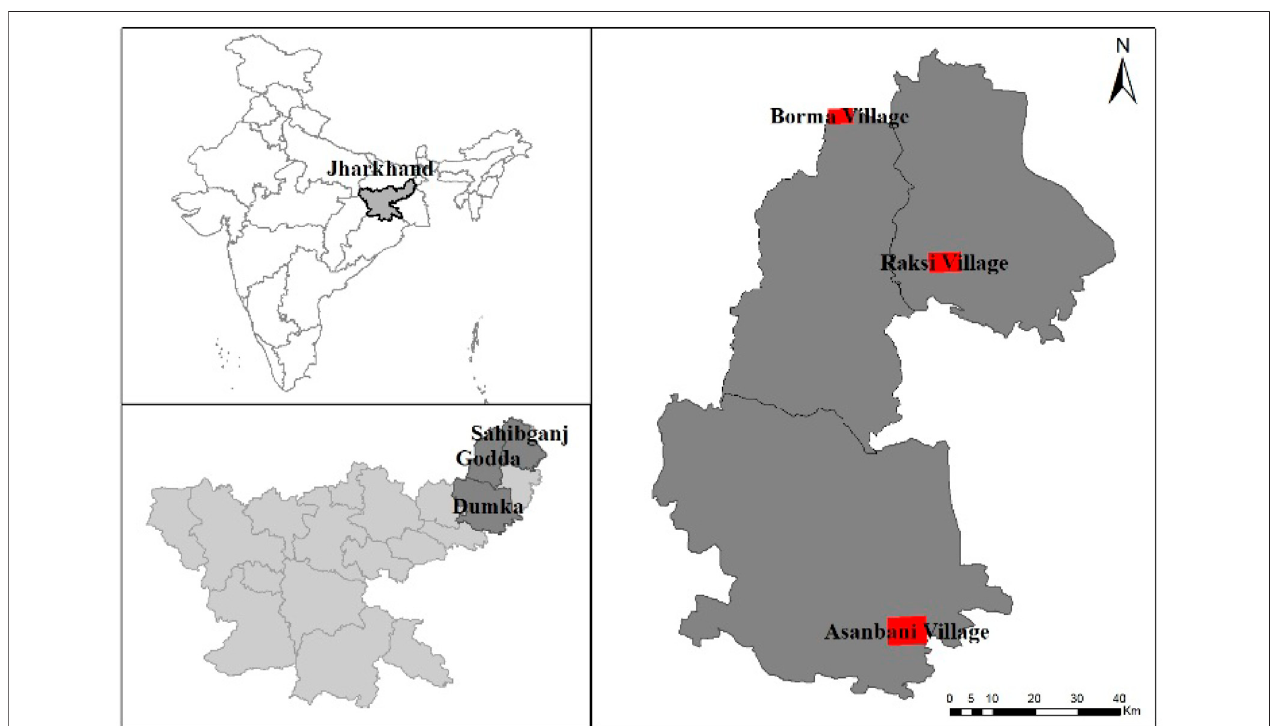
FIGURE 1 | Location of the three study villages in Jharkhand state (Map not to